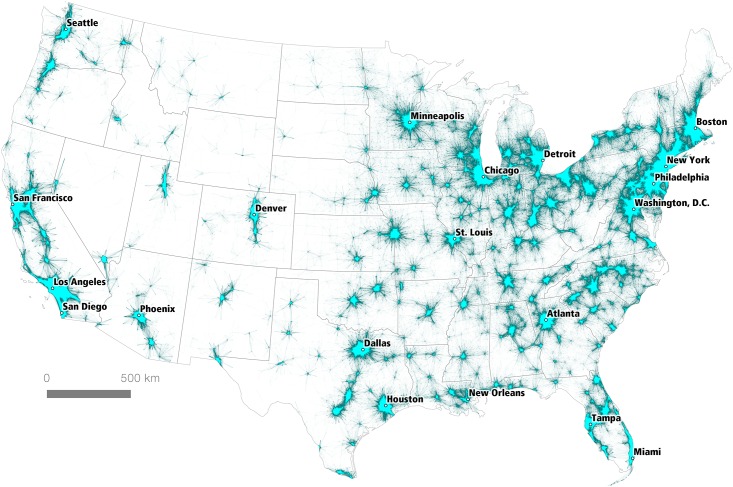
Tract-to-Tract Commutes of 160km or less.